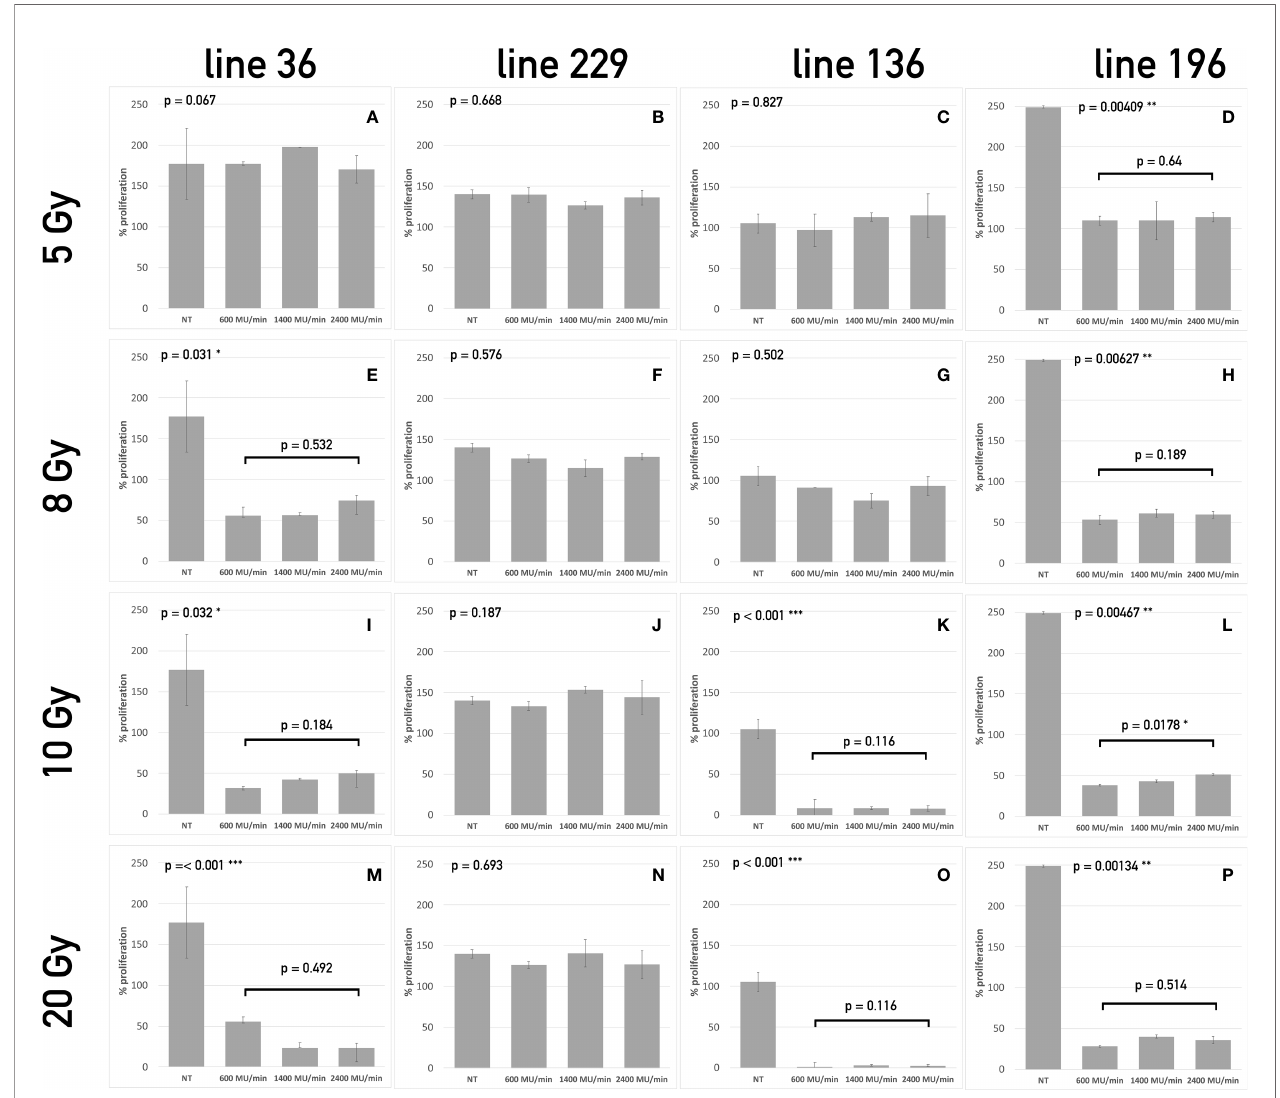
FIGURE 1 | Proliferation assay of the four CSCs line treated with different dose/dose rate combinations. The bars represent cell proliferation of lines 36 (A, E, I, M) , 229 (B, F, J, N) , 136 (C, G, K, O) , and 196 (D, H, L, P) treated with 5 Gy (A – D) , 8 Gy (E – H) , 10 Gy (I – L) , and 20 Gy (M – P) compared to untreated cells at 14 days after treatment. For each dose, three different dose rates have been used. On the top left corner of each graph, the p-value of the repeated measure ANOVA test used to assess differences between treated and untreated cells. When signi fi cant differences exist, the p-value of the repeated measure ANOVA test between treatments (dose rates) is also reported. (* symbols are used to summarize the number of 0 digits after the decimal sign in signi fi cant results. * p < 0.05, ** p < 0.001, *** p <